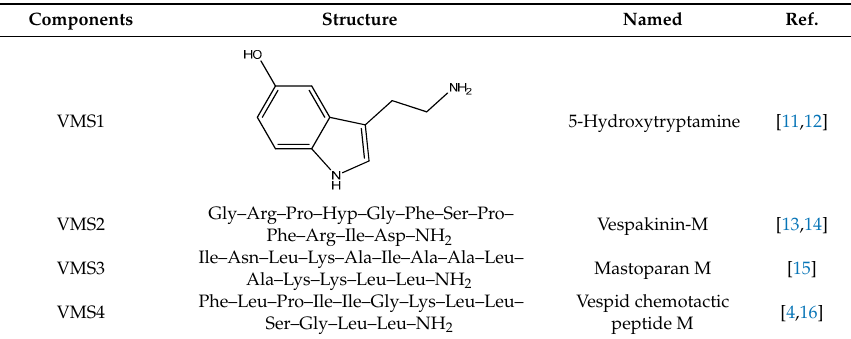
Figure 4. Representative MS and MS/MS analyses of the peptide in this work. ( A ) The matrix-assisted laser desorption/ionization time of flight mass spectrometry (MALDI-TOF-MS) profile of VMS2. The ion at m / z 1361.6854 was the quasi-molecular ion [M + H] + . ( B ) MALDI-TOF-MS/MS characterization of the selected ion (1361.6854) from (A) and the deduced sequence. Lines ( ) indicate the possible amino acid sequences. Table 1. Structure of VMS1, VMS2, VMS3, and VMS4.